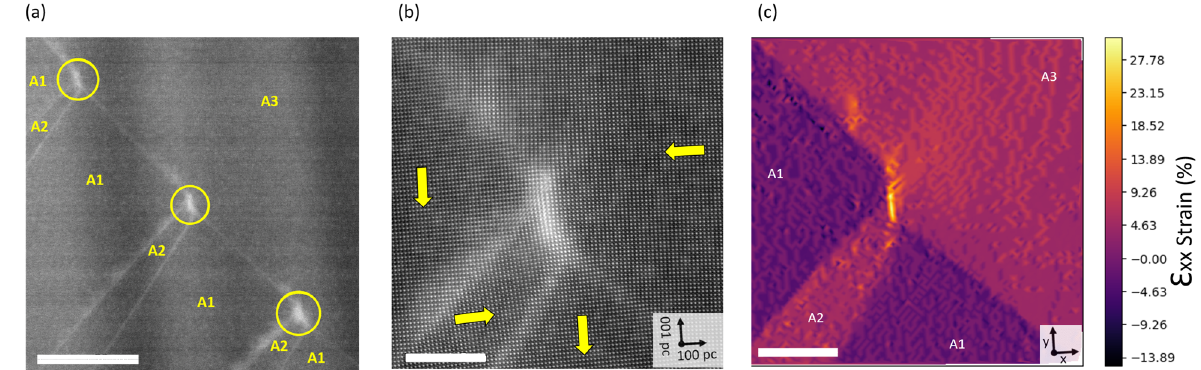
Fig. 1 Medium and high-resolution images of the array of charged needle points. a Medium angle annular dark fi eld (MAADF) scanning transmission electron microscopy (STEM) image of an array of charged needle-point domains. Scale bar = 40 nm. b High-resolution MAADF STEM image showing atomic-level detail of the structural changes across the 180° charged domain wall. This domain wall forms a “ nanochannel ” of cross-section 5 nm × 2 nm running through the sample. Spontaneous polarisation interpreted from ( c ) marked with yellow arrows. Scale bar = 8 nm. c Quantitative strain map of ( b ), measured with respect to the theoretical cubic lattice parameter at room temperature (3.929 Å). There is ~29% strain at the junction where the structure ruptures. Scale bar = 8